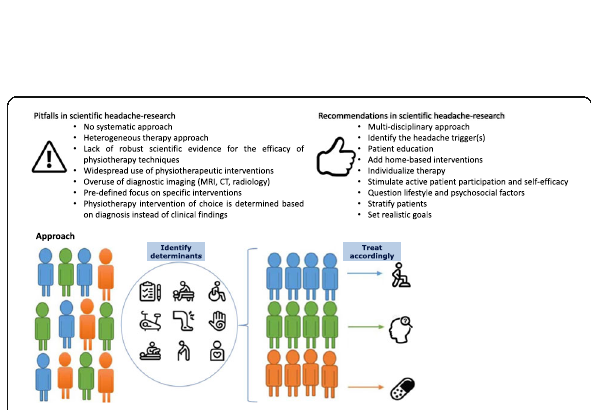
Fig. 2 (abstract P73). Visualisation of determinant-based physiotherapeutic interventions in patients with